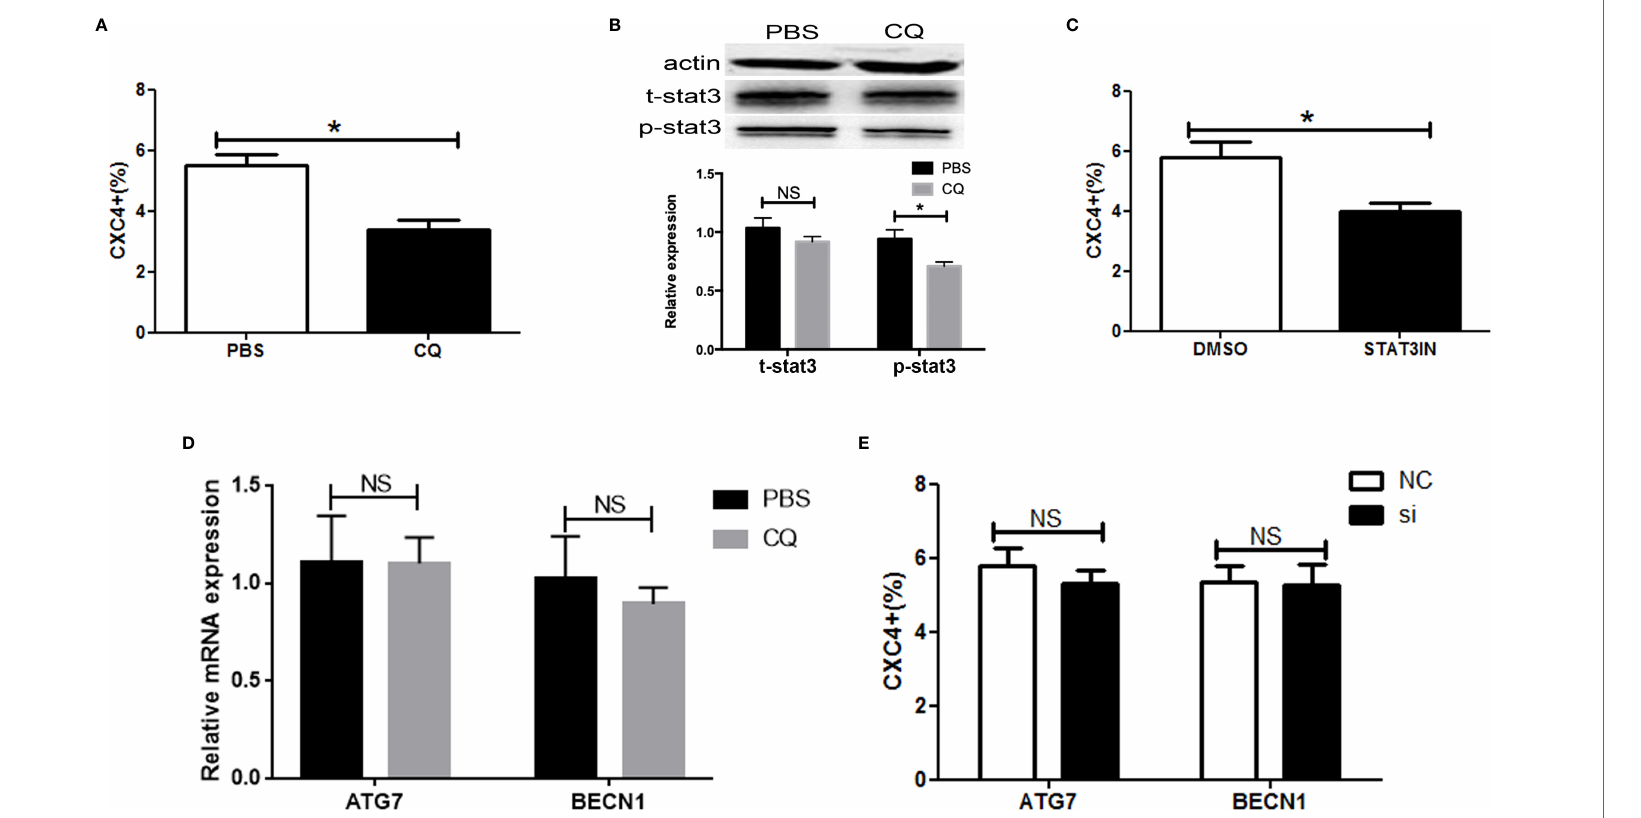
FIGURE 5 | Chloroquine targeted CXCR4-positive ESCC cells via STAT3. (A) The expression of CXCR4 was analyzed by fl ow cytometry. (B) The activity of pSTAT3 and tSTAT3 were measured by western blotting in ESCC cells with or without CQ treatment (5µM). (C) The expression of CXCR4 was analyzed by fl ow cytometry in ESCC cells with or without STAT3 inhibitor (S3I-201, Sigma, USA) treatment. (D) The expression analysis of ATG7 and BECN1 was detected by real time PCR in ESCC cells with or without CQ treatment (5µM). (E) The expression of CXCR4 was analyzed by fl ow cytometry in ESCC cells after ATG7 or BECN1 knockdown. *P <